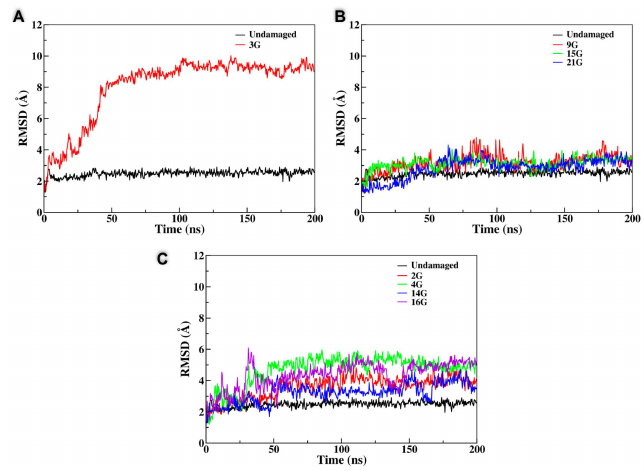
Figure 3. Time series of the root mean square deviation (RMSD) for all the di ff erent classes of G4, leading to the total destructuration of the G4 ( A ), to the substitution of the AP site in the central tetrad ( B ), and to the destructuration of the peripheral plane ( C ). The RMSD of the undamaged G4 is also reported for comparison.